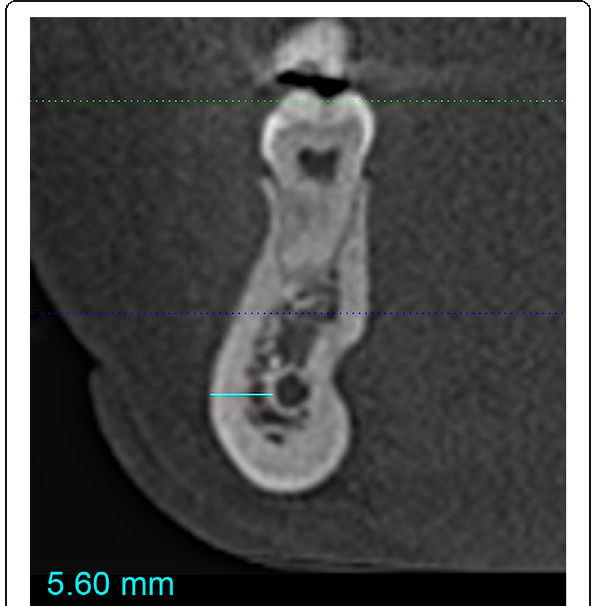
Fig. 1 Measurement of mandibular bone thickness, defined as the distance between the lateral wall of the mandibular canal and the lateral mandibular compact bone (solid turquoise line)